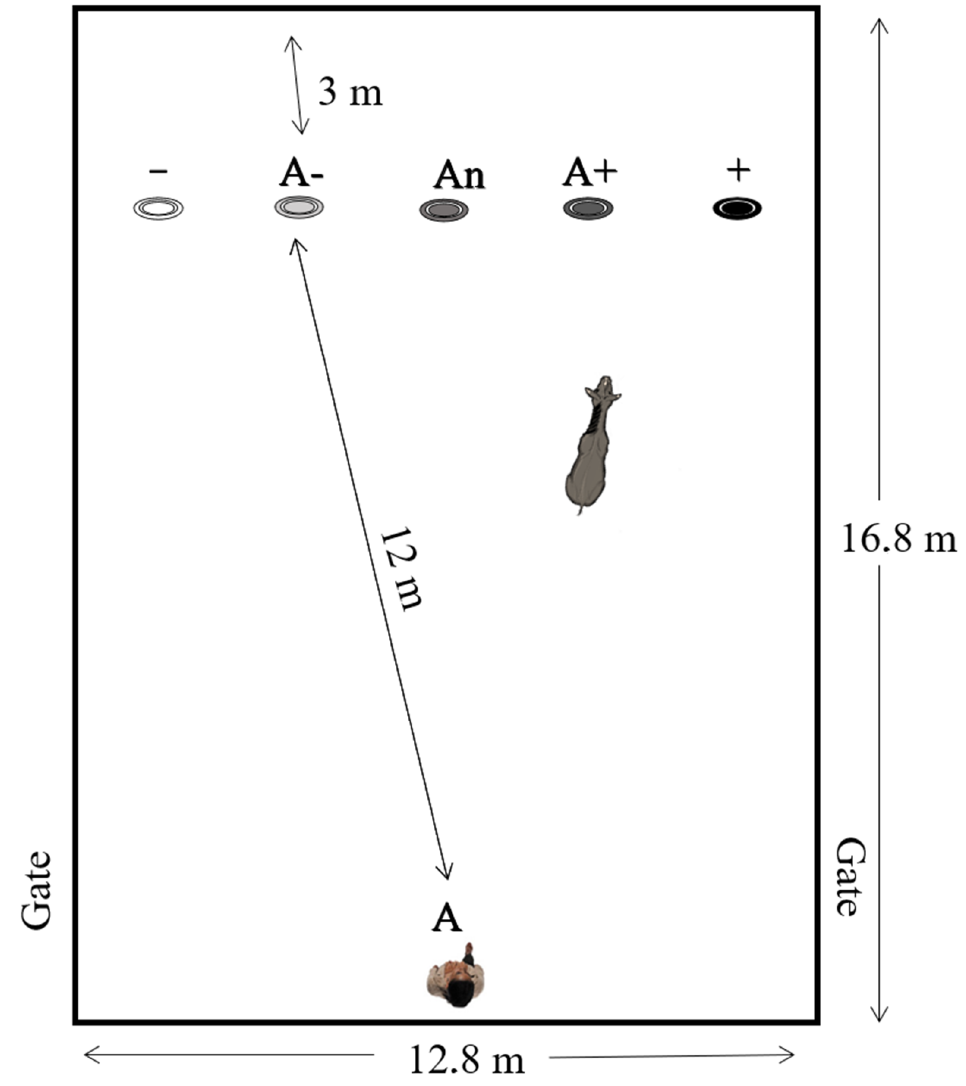
Figure 1. Experimental area. Experimental set-up during judgement bias trials. Position of the positive goal (+; right or left depending on the donkey, rewarded), the negative goal ( − ; opposite side as the rewarded one, unrewarded), the ambiguous goals (A − , An, A+; equidistant angles between the positive and negative buckets), the start (A) and entrance gates. The latency to reach the goal was measured as the time to go from A to one metre away from the tested bucket.